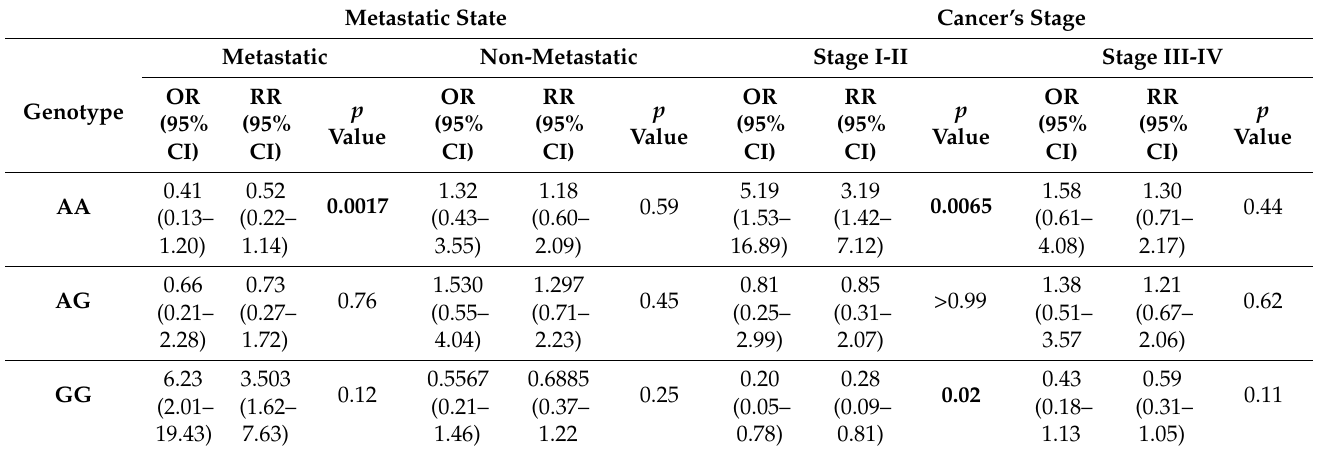
Table 5. Association of K359R (rs1331232028) SNP with Metastatic State and Stage of Ovarian Cancer